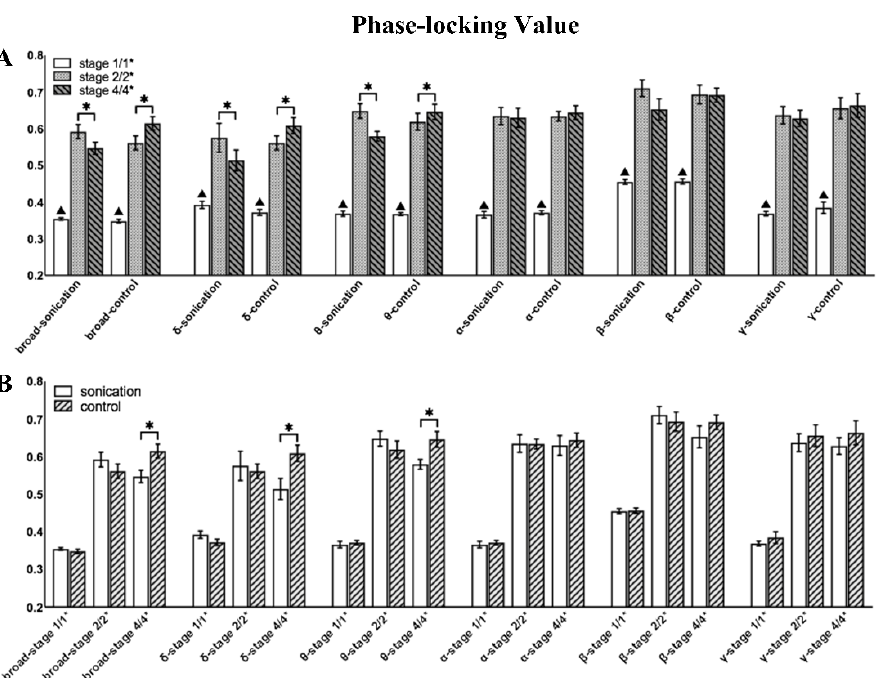
Figure 10. Mean phase-locking value (PLV) for all filtered frequency bands (delta 0.1–4 Hz, theta 4–8 Hz, alpha 8–13 Hz, beta 13–30 Hz and gamma 30–48 Hz) and the broad-filtered signal (0.1–48 Hz). ( A ) Within-group comparisons of the mean PLV at the different stages; (cid:78) represents a significant difference between Stage 1/1* and Stage 2/2* ( p < 0.05). ( B ) Between-group comparisons of the mean PLV between Group 1 and Group 2 (‘Sonication’ represents Group 1 and ‘Control’ represents Group 2). * indicates significance ( p <